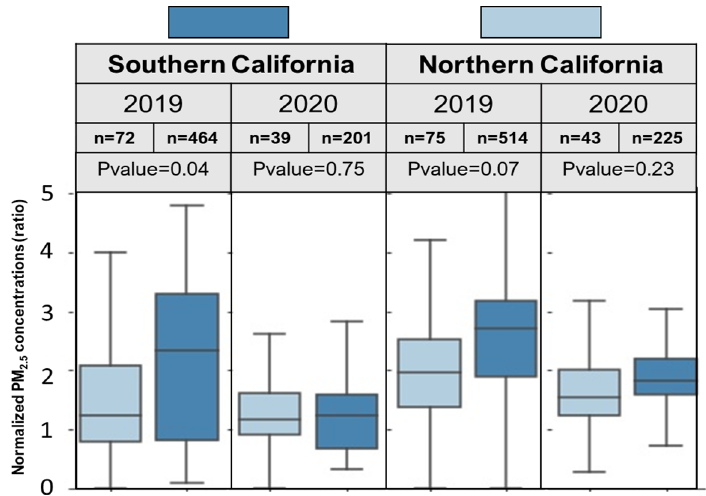
Figure 3. Comparison of the normalized daily PM 2.5 concentrations (average over July 4th and 5th) in cities where firework displays were either allowed or not allowed in southern and northern California, where “ n ” shows the number of census tracts within each category and the p -value shows the t -test results between census tracts where fireworks were either allowed or not allowed in each year.